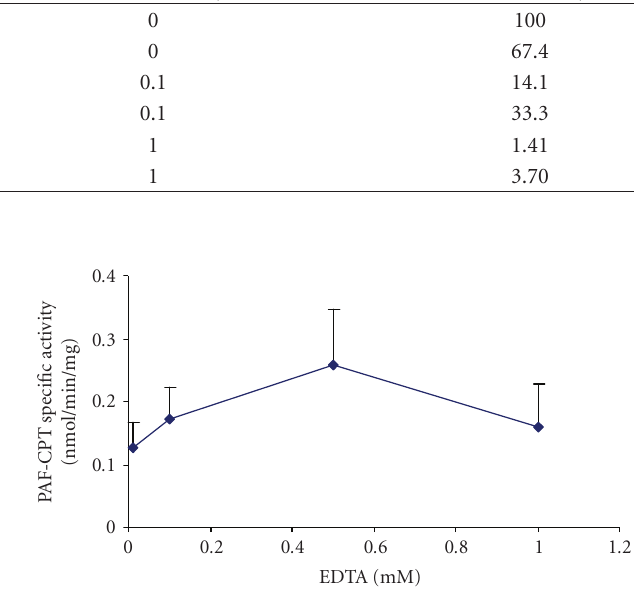
Figure 4: E ff ect of the concentration of the chelate reagent EDTA in the presence of 20 mM Mg 2+ on PAF-CPT specific activity of mesangial cells: microsomal fractions of HMC 0.05 mg/mL were in- cubated in the presence of di ff erent concentrations of EDTA. Results are the average of two independent determinations using di ff erent enzyme preparations performing duplicate